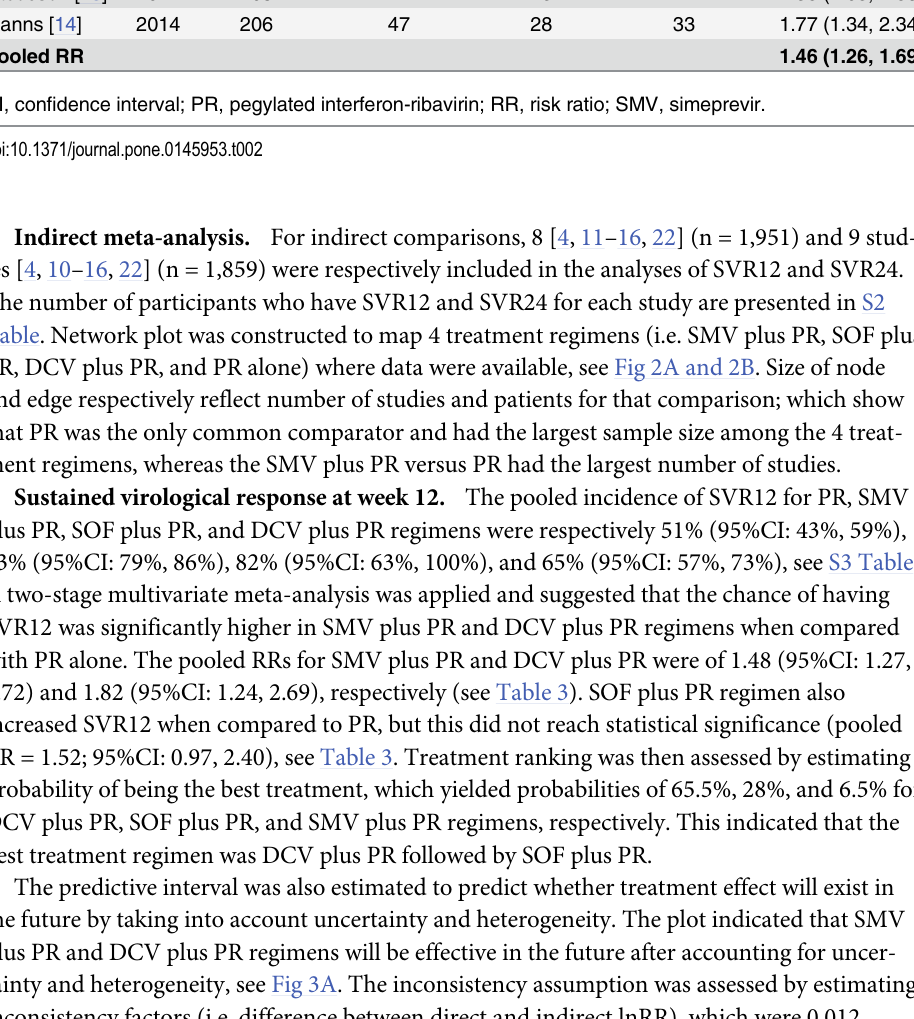
Sustained virological response at 24 weeks